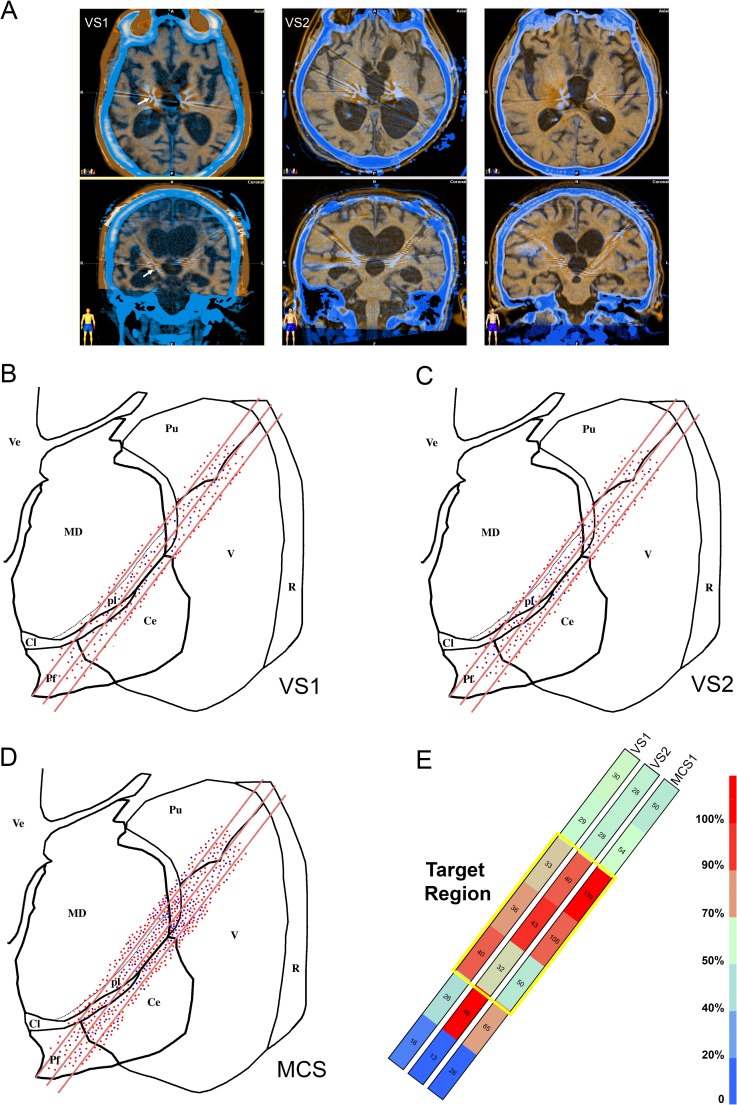
Microelectrode recordings from the thalamus of patients affected by DOC.(a) Early postoperative TC fused to MRI T1 weighted images showing the position of the definitive electrodes for thalamic stimulation in all patients (E: electrode). The stimulating electrodes were implanted following the trajectory of one of the recording microelectrodes thus their position marks the intra-thalamic region of the microelectrode recordings. In the upper row we show the axial images corresponding to the patients, in the lower row the coronal ones. The withe arrows in VS1 indicate the position of the electrode in the thalamus. (b-d) Topographic distribution of the 950 thalamic units recorded in the 2 VS/UWS patients (b: VS1, c: VS2) and in the MCS patient (d: MCS) shown on coronal view of the left thalamus at the level of the microelectrode trajectories. Only the last 20 mm of the trajectories of the 3 microelectrodes contained in the plane of the section are outlined (red segments). All recorded units are indicated at their position. Units recorded by the electrodes contained in planes parallel to that outlined in the figure were projected to the represented plane and all units recorded in the right thalamus were also projected to the corresponding position of the left one. Red dots: SN, blue dots: BN. Pf: parafascicular nucleus, MD: mediodorsal nucleus, pl: Paralaminar part of mediodorsal nucleus, Cl: central lateral nucleus, Ce centromedian nucleus, V: ventral nuclear group, Pu: Pulvinar, R: reticular nucleus. (e) Heatmap of the distribution of the recorded units in the three patients. The represented recordings were obtained every 1mm in 21 steps starting from 0 located dorsally and lateral in the thalamus to 20, ventral and more medial close to the third ventricle. Recordings were grouped in 7 bins containing the cells collected by multiple electrodes bilaterally in 3 recordings step each. The color of each bin represent the percentage of total neurons recorded present in each bin, the numbers of neurons are written inside each bin. The yellow rectangle outlines the 2D projection of the 3D region where, anatomically, the microelectrodes had the maximal chance of recording from the nuclei representing the intended the target for stimulation. A color scale is provided with the indication of percentages corresponding to each color.